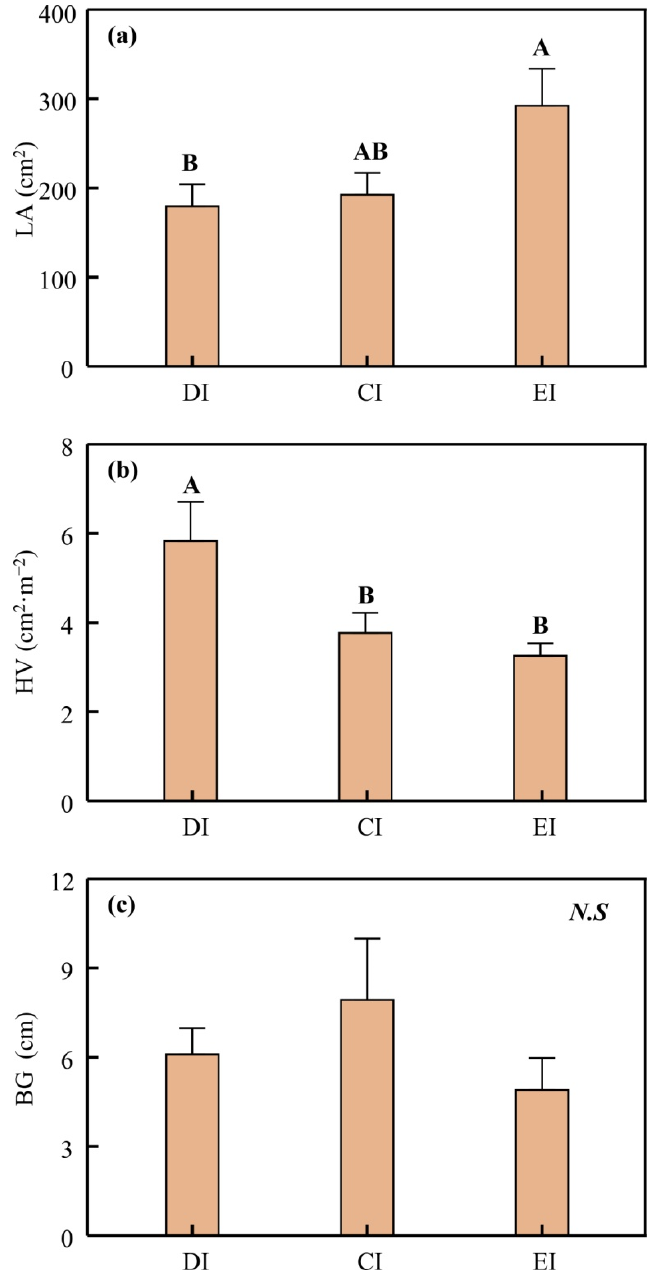
Figure 5. Branch end leaf area (LA, ( a )), Huber value (HV, ( b )) and Branch growth (BG, ( c )) at different irrigation levels. Different capital letters indicate significant differences between different treatments at the same tree height; N.S indicates no significant difference between treatments ( p < 0.05, mean ± standard error, n =